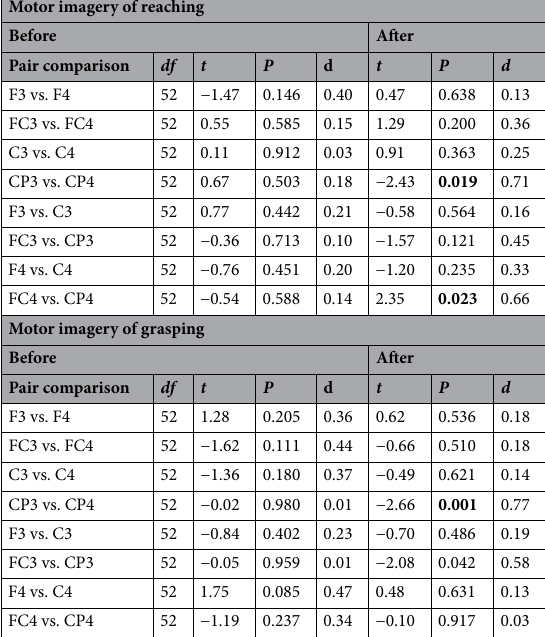
Table 6. Results of pairwise comparison for ERP latency parameters between electrodes located above the right compared to the left hemisphere, and between electrodes located above the premotor cortex compared